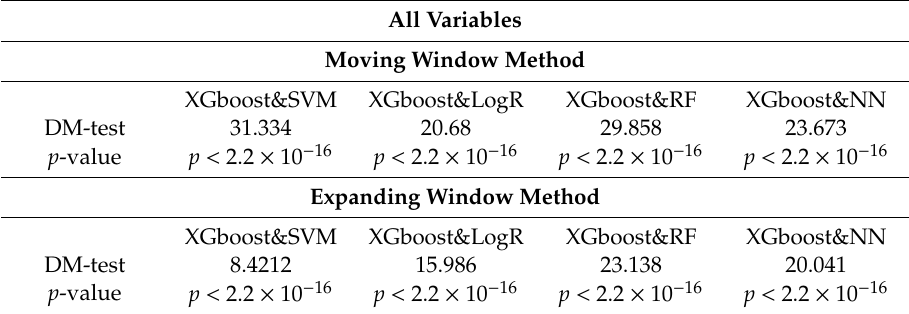
Table 9. The results of the Diebold–Mariano test (all